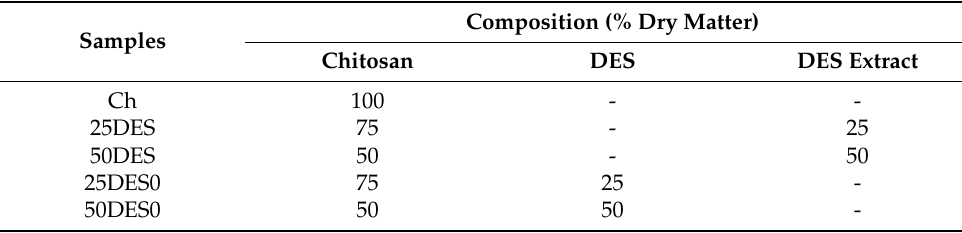
Table 2. Composition and symbolization of samples in the form of